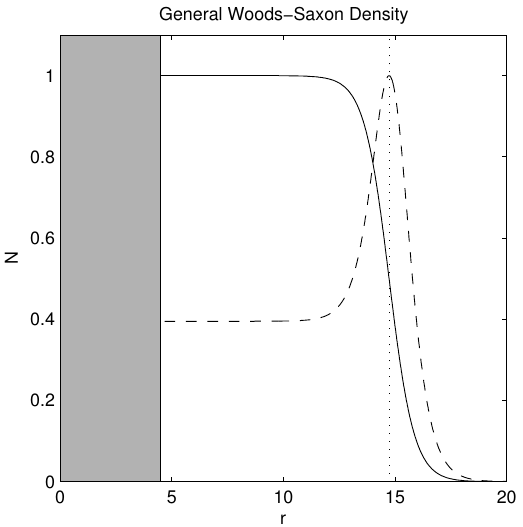
Figure 7. The general Woods-Saxon function. The dashed curve ( a = 1, C = 8) shows a density N ( r ) with a discrete maximum at r ECS . This function does not vanish at the CO surface at R , shown by the shaded portion on the left of the figure. The solid curve ( a = 1, C = 0) represents the extreme case in which the density does not monotonically decrease toward the star. Both of these functions produce regions of constant density above the stellar surface. The vertical dotted line denotes the position of r ECS